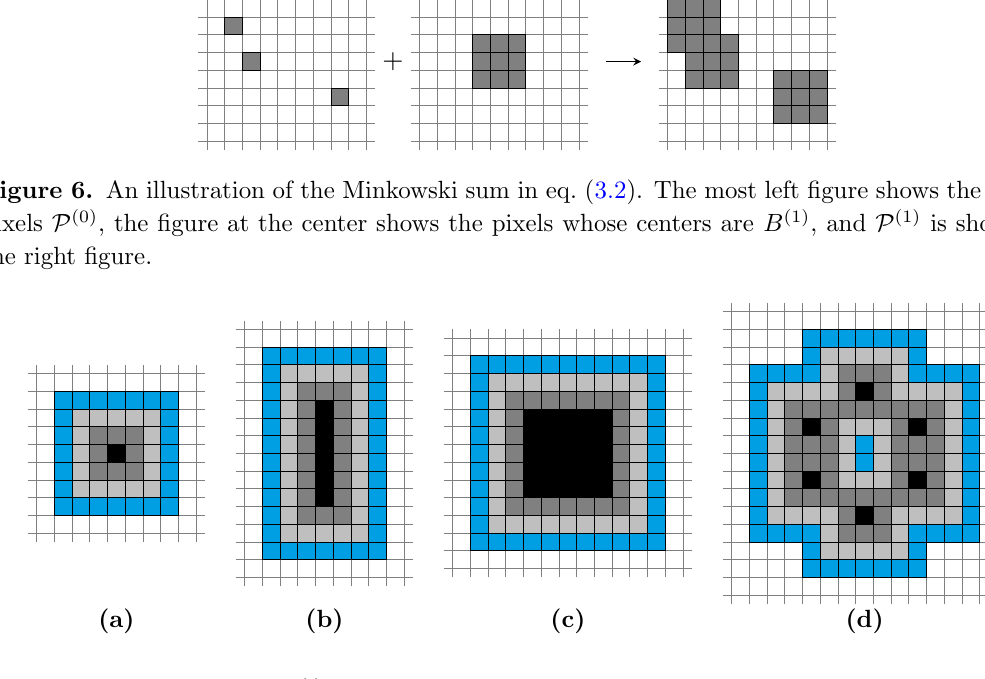
Figure 7. Illustrations of P ( i ) for (a) an isolated pixel, (b) a line of pixels, (c) a 5 (cid:2) 5 square of pixels, (d) a ring of six pixels. For each plot, black pixels belongs to P (0) ; dark gray, light gray, blue pixels are the di(cid:11)erence P ( i ) n P ( i (cid:0) 1) for i = 1 ; 2 ; 3, respectively. is proportional to the area A ( i ) of pixels in the cover P ( i ) because each pixel has the same area ((cid:1) R ) 2 ,